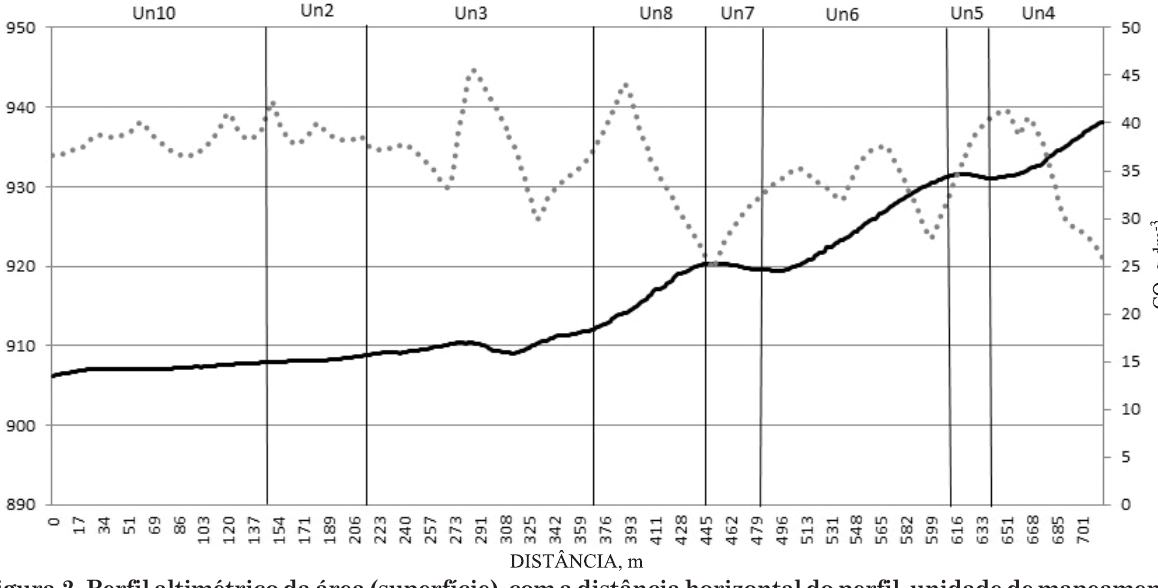
Figura 2. Perfil altimétrico da área (superfície), com a distância horizontal do perfil, unidade de mapeamento e teor de carbono em g dm -3 . Compartimento inferior – unidades 2 e 10; compartimento médio – unidades 2, 3, 7 e 8; compartimento superior – unidade 4, 5